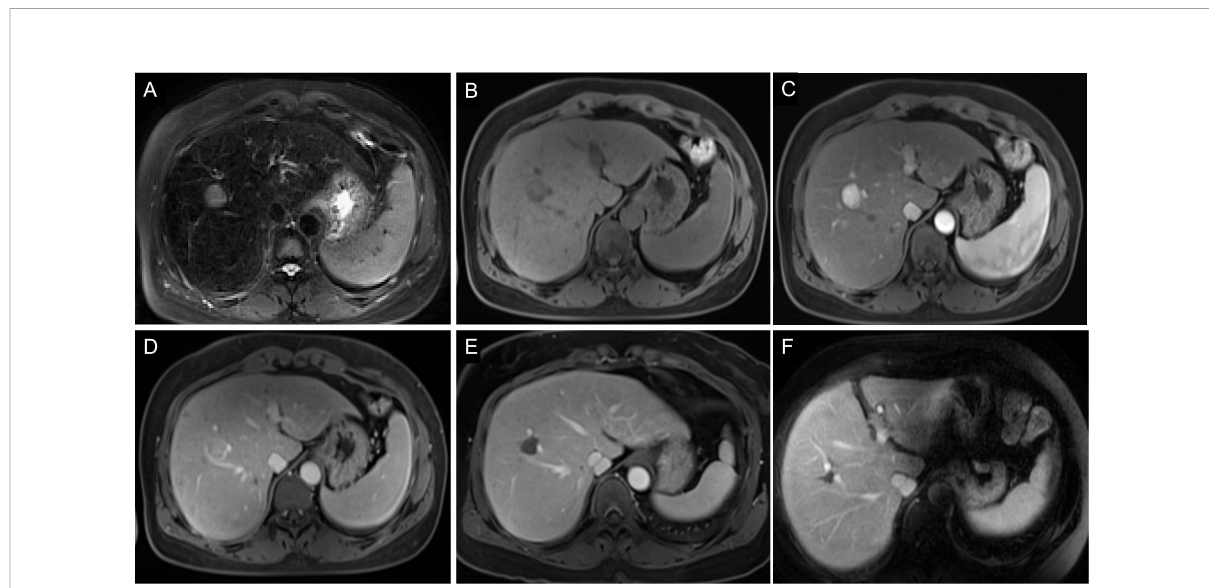
FIGURE 7 Images of a 54-year-old man with HCC without early recurrence. (A-D) The tumor demonstrated the typical enhancement mode of “ fast in and fast out ” . (E) There was no obvious blood supply to the tumor after RFA. (F) The patient was followed up for 5 years without tumor recurrence. The patient had a single tumor. The Rad-score of this patient was 1.16, and his ALB was 50.9g/l. Based on the Nomogram, his total point was about 63, indicating the risk of ER was less than 0.1.